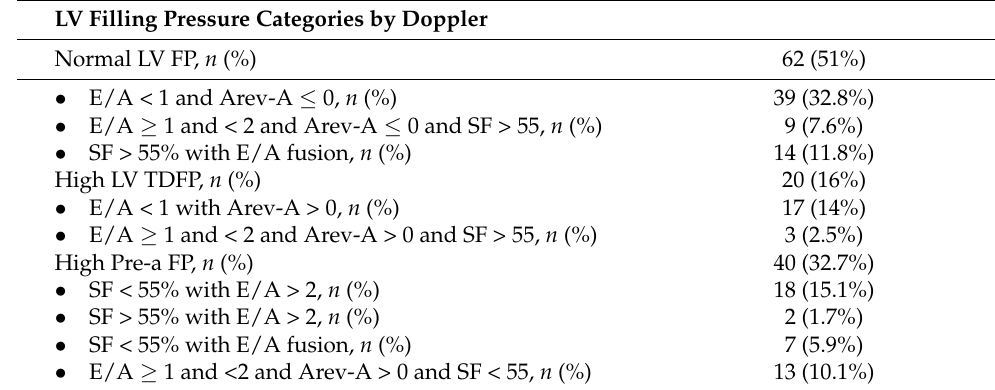
Table 2. Left ventricular filling pressure as predicted by means of transmitral and pulmonary venous flow Doppler recording in the initial study group of 122